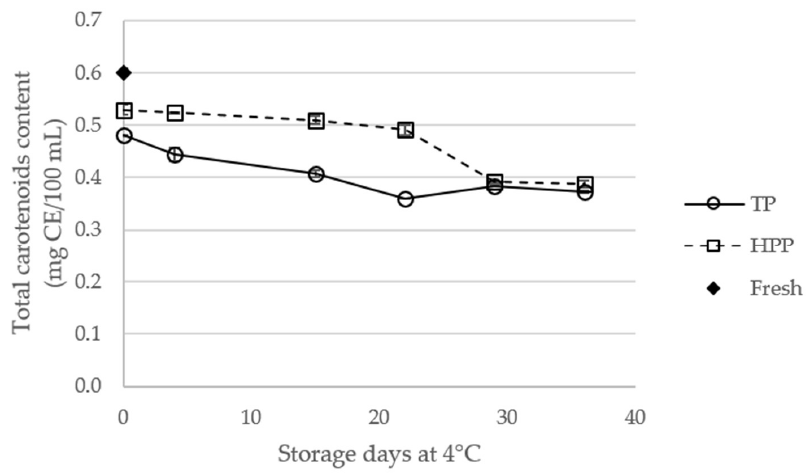
Figure 4. Total carotenoid content (expressed as β -carotene equivalents (CE)) of fresh and thermal pasteurized (TP) and high-pressure processed (HPP) orange juices during storage at 4 °C.